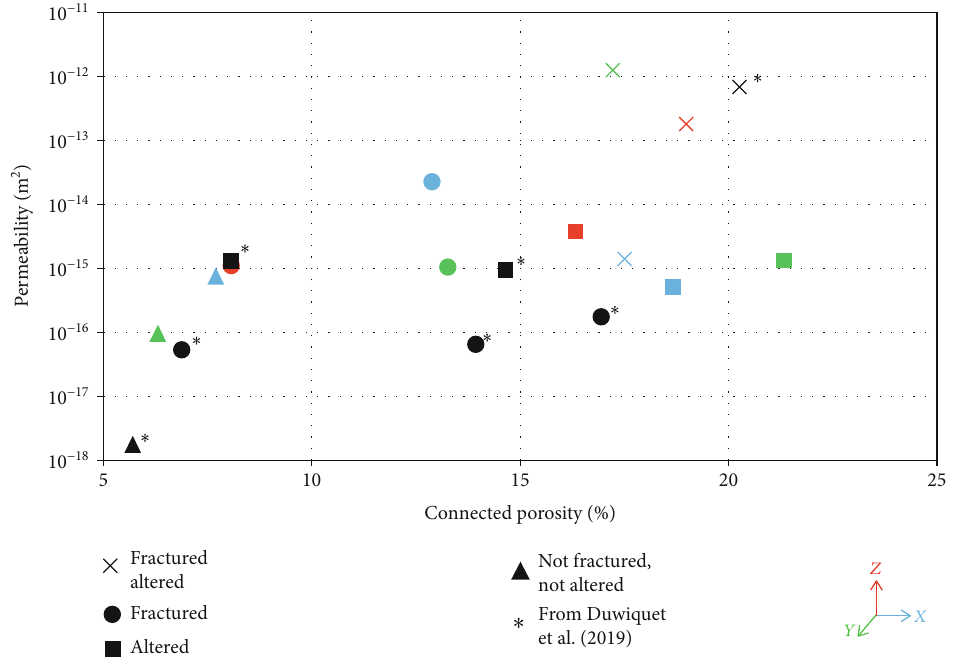
Figure 10: Permeability as a function of connected porosity for altered, fractured, altered and fractured, and unaltered and unfractured samples from the Peyrouses 1 borehole (see location in Figure 1). ∗ Data from Duwiquet et al. [51]. The X , Y , and Z directions (respectively, in blue, green, and red) correspond to the sampling direction for each core for the same facies. Measurement uncertainty corresponds to the size of the